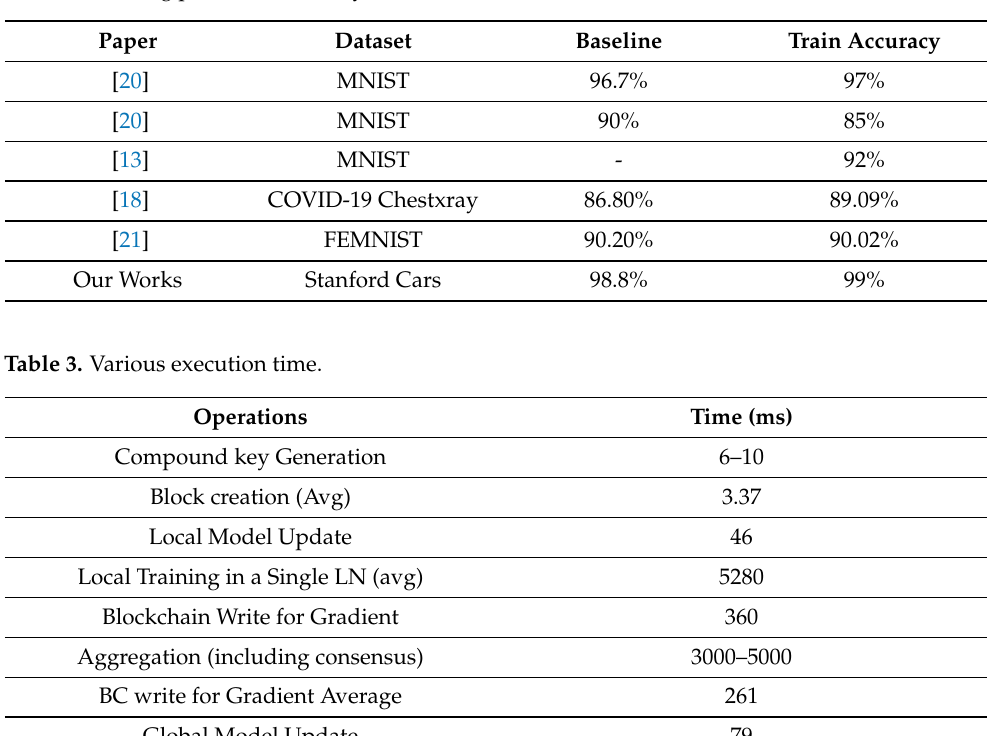
Table 2. Training performance analysis.